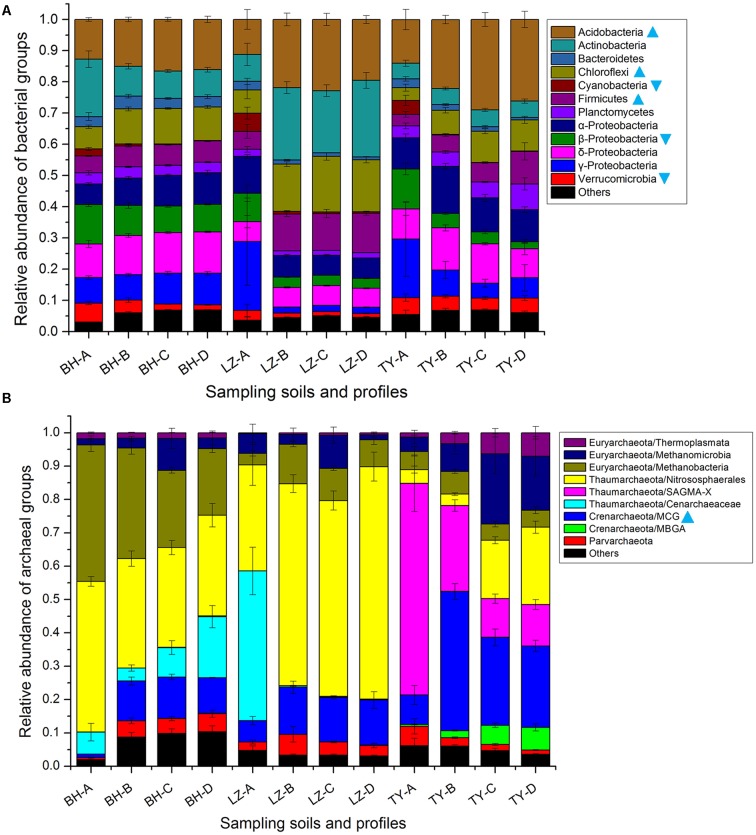
Dominant taxonomic groups of bacterial (A) and archaeal (B) groups in four soil profiles of three paddy soils. Cyan triangles denote that the relative abundance of the group uniformly decreased along depth layers within each soil type, cyan inverted triangles denote that the relative abundance of the group uniformly increased along depth layers.